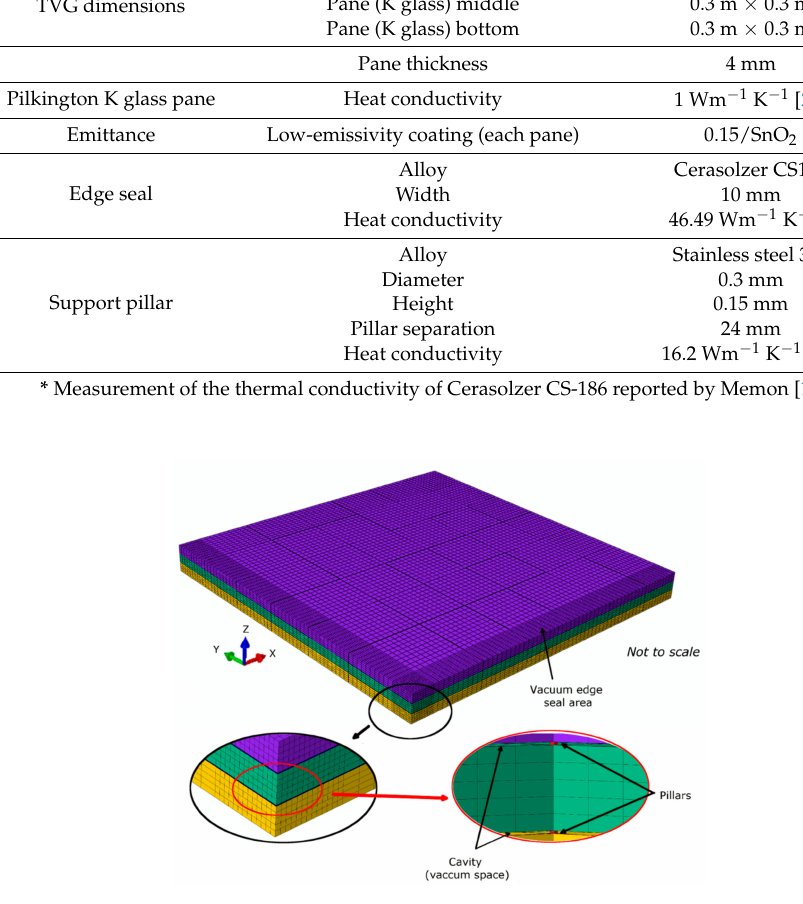
Figure 1. A quarter portion (size of 150 mm × 150 mm) of the 10-mm wide edge-sealed triple vacuum glazing showing the developed finite element